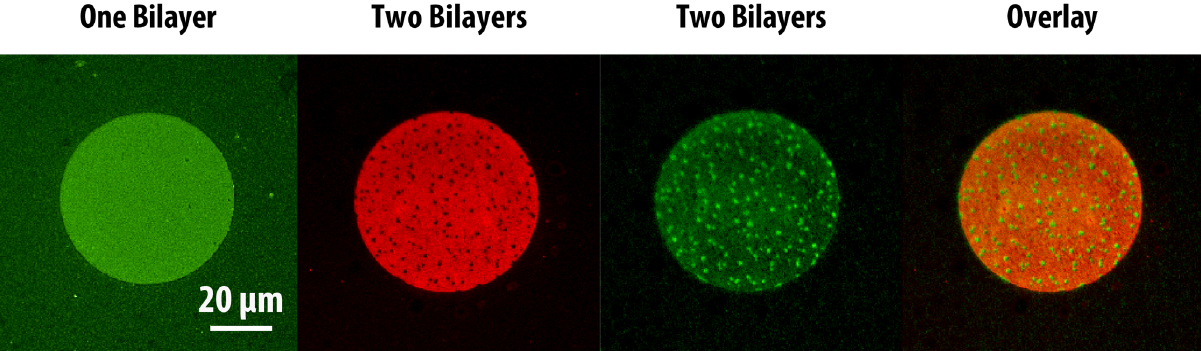
Figure 4. Epifluorescence images showing patterns of two-bilayer SLB stacks consisting of a homogeneous bottom bilayer and a phase-segregated top bilayer. The first lipid bilayer (composed of DOPC: DOTAP: DHPE-OG) is observed in the green channel, while the second lipid bilayer (composed of DOPC: DSPC: DOPS: DHPE-LR) can be observed in the red channel. The formation of the second bilayer leads to significant fluorescence intensity changes in the first bilayer. The overlaid image of the two bilayers shows the fluorescence patterns are complimentary, due to